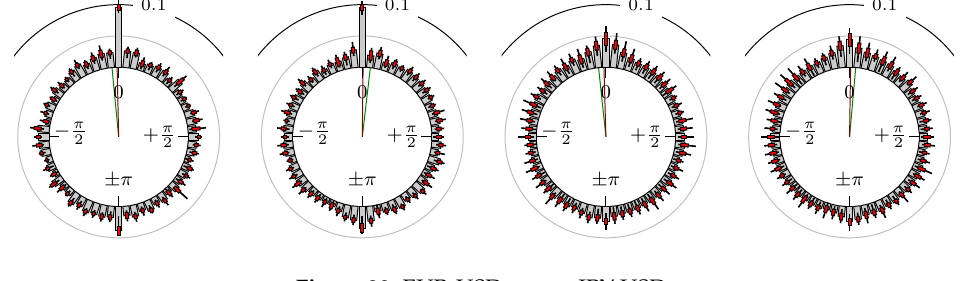
Figure 20. EUR-USD versus JPY-USD.